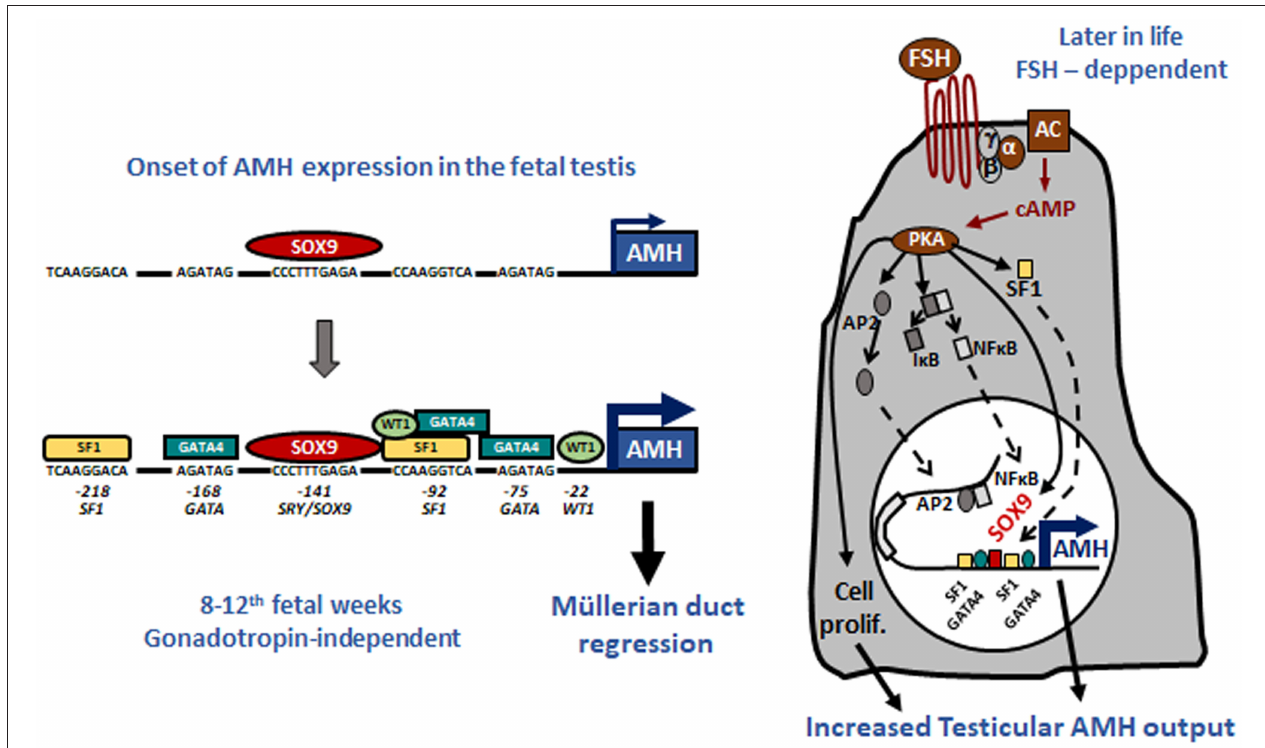
FIGURE 1 | Upregulation of AMH production in testicular Sertoli cells. Left: onset of AMH expression in early fetal life is independent of gonadotropins and depends on transcription factors SOX9, which triggers AMH expression, and SF1, GATA4, and WT1, which further increase AMH transcription by binding to specific response elements on the proximal AMH promoter. Right: increase of testicular AMH production in response to FSH, involving the FSH receptor-Gs α protein-adenylate cyclase (AC)-cyclic AMP (cAMP) pathway, which activates protein kinase A (PKA)-mediated induction of SOX9, SF1, NF κ B, and AP2. These factors bind to their specific response elements on the AMH promoter. Reproduced with permission from ref. ( 11). Copyright © 2011 the American Physiological Society and © 2020 MDText.com,